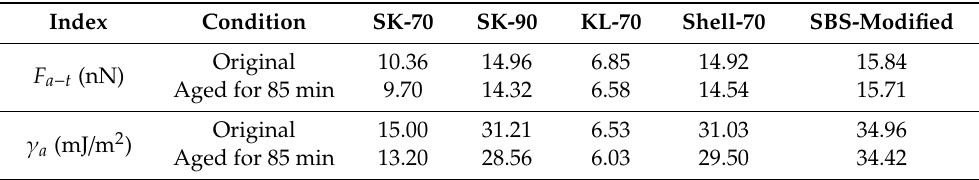
Table 5. The overall surface energy of different asphalts before and after aging.